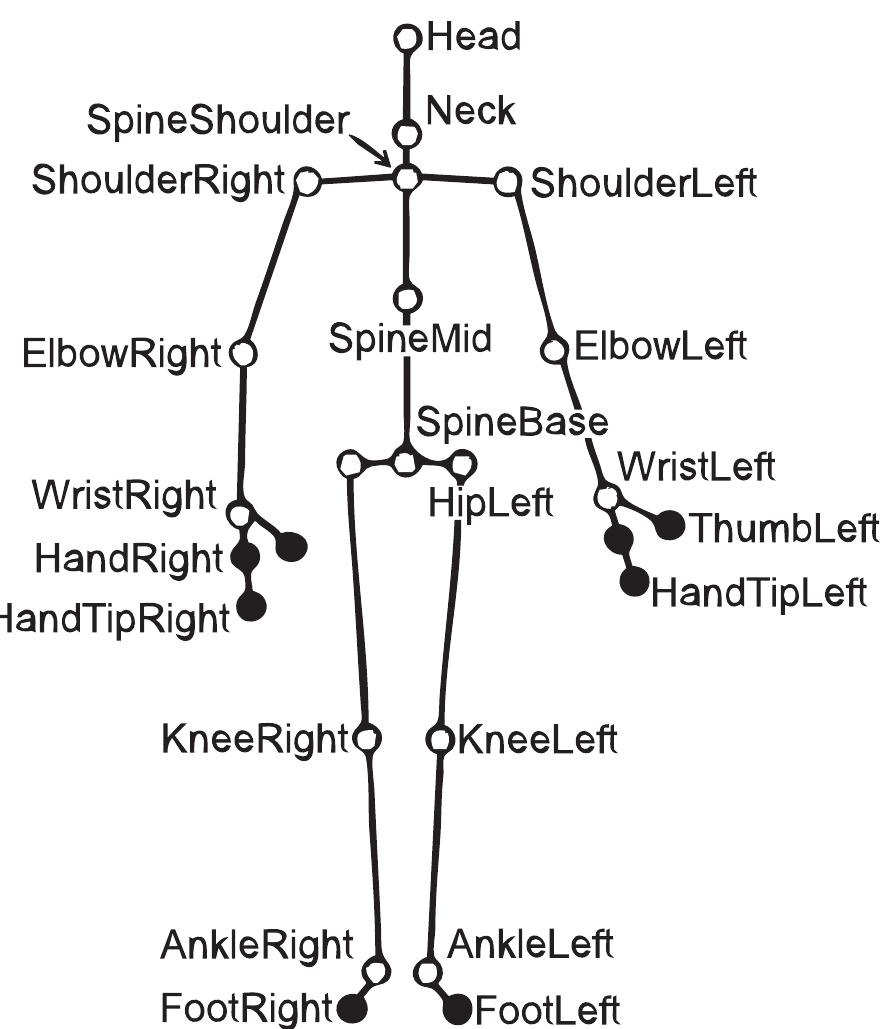
Fig 1. Twenty five joints of the virtual skeleton characteristic to the second generation of Kinect. The 17 joints that were analysed in this study (see Methods) are marked as white, as opposed to the skipped eight joints, which are marked as